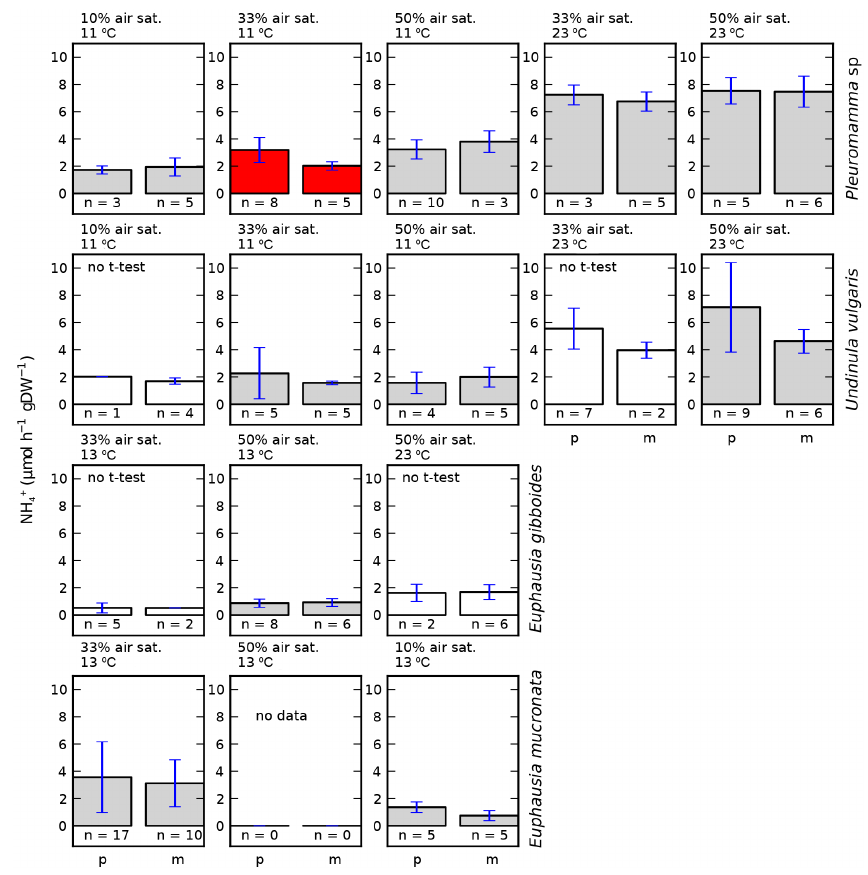
Figure 4. Weight-specific ammonium excretion rates of calanoid copepods and euphausiids at different temperatures, air saturation and CO 2 -levels. p = CO 2 -plus, m = CO 2 -minus. Red barplot colour indicates a statistically significant difference ( t test, p< 0 . 05) between CO 2 - plus and CO 2 -minus treatments. Each row contains data for only one species, with low temperatures on the left side of the row and high temperatures on the right side and air saturation increasing from left to